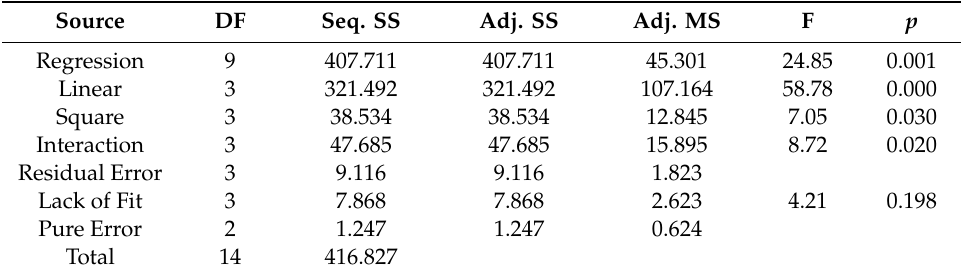
Table 6. ANOVA test results of the developed response surface model for MRR.